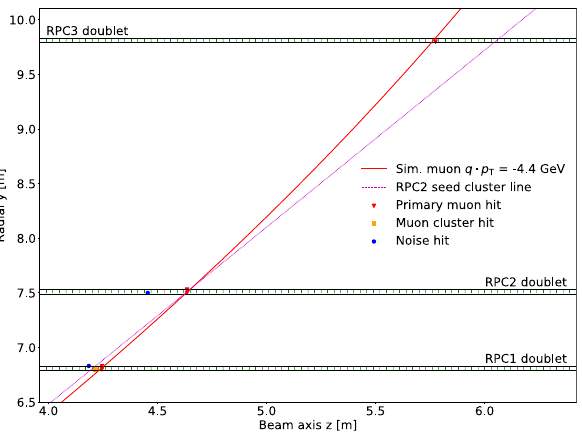
Fig. 2 Illustration of one simulated muon candidate traversing the RPC detector. Six horizontal solid black lines represent six layers of the current RPC detector. Small vertical lines along these lines repre- sent strip boundaries. Solid red line represents the muon track. Dotted magentalinepassingthroughthereconstructedclusterintheRPC2layer is referred to as the seed line in the text. Coloured markers represent simulated RPC hits